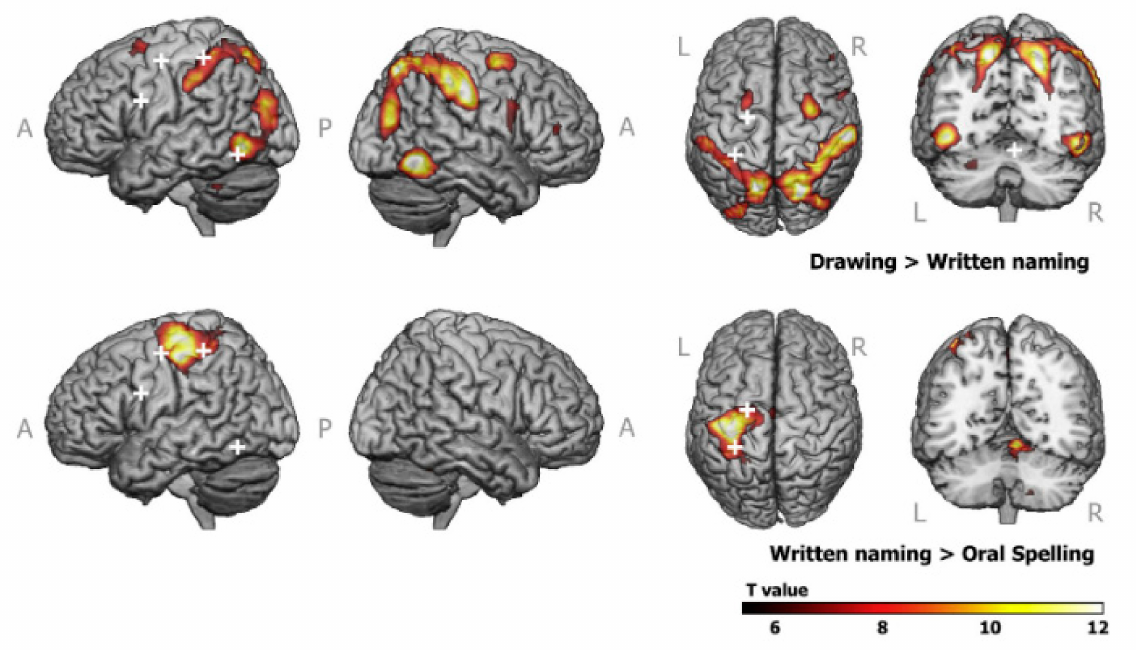
Figure 9. Activation maps of two major task contrasts in an fMRI study of writing behaviour. Top row: drawing vs. written naming; bottom row: written naming vs. oral spelling. A family wise error of p = 0.05 was used to threshold the activation maps. The white crosshairs indicate regions that were analyzed outside the scope of this review. See [22] for further details. A = anterior; P = posterior; L = left; R = right. Taken from [22]. Copyright © 2016 Elsevier Ltd., Amsterdam, NX,